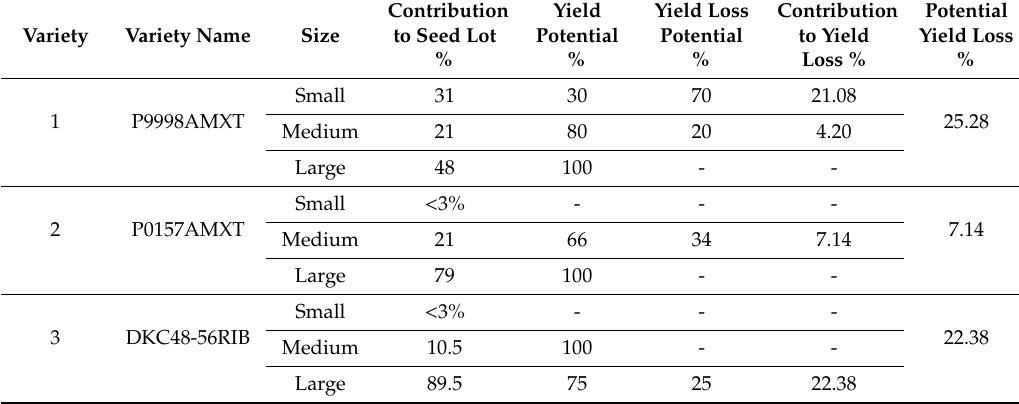
Table 1. Potential yield loss calculations of three corn hybrid varieties based on seed size and vigor index-2